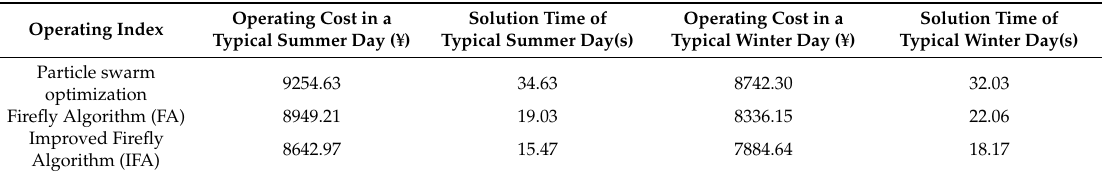
Table 6. Comparison of the performance indexes of the